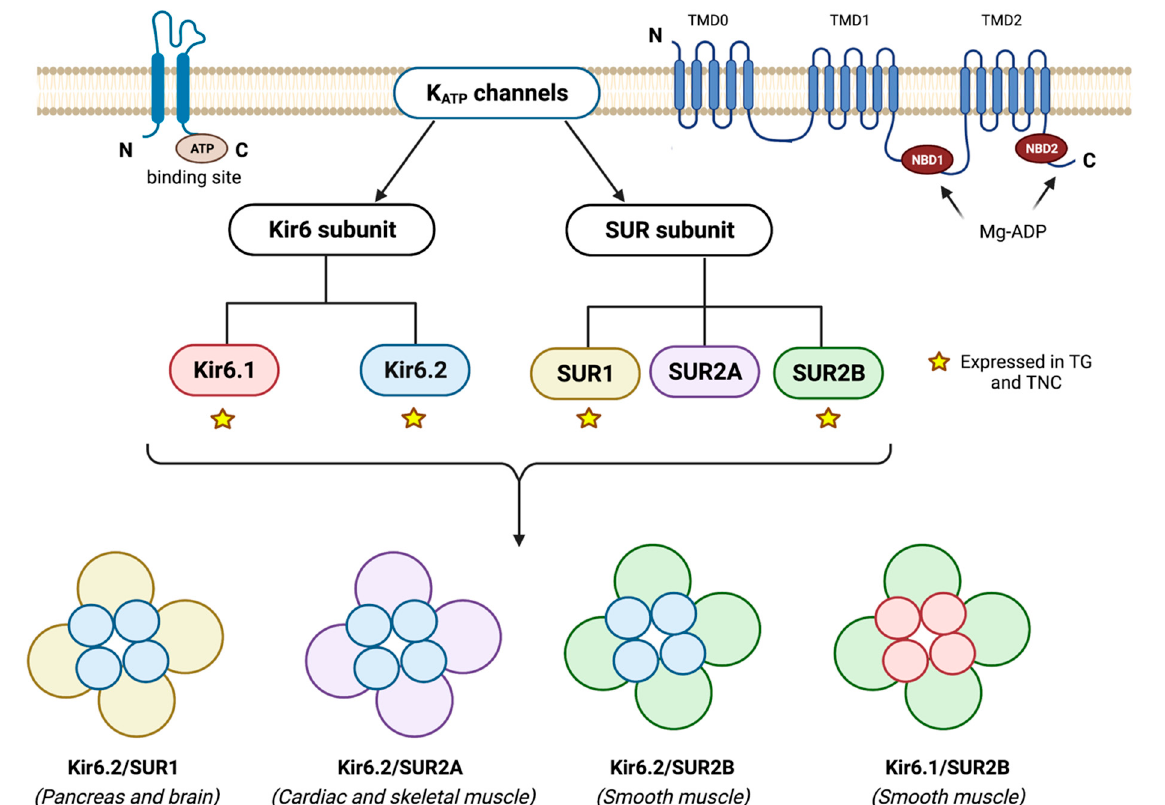
Figure 2. Structure of the K ATP channel. The tetrameric K ATP channel complex is assembled by four Kir6 and four SUR subunits. The Kir6 subunit is a 2 TMD with an ATP-binding site, whereas the SUR subunit consists of 3 components (TMD0, TMD1, and TMD2) with 5–6 transmembrane domains in each. The SUR subunit includes the nucleotide-binding domain (NBD) for Mg-ADP. The distinctive subtypes in each subunit give rise to different combinations and properties of the K ATP channels. Kir6.1, Kir6.2, SUR1, and SUR2B are expressed in TG and TNC. The occurrence of these combinations is presented. Kir6 = inwardly rectifying K + channel; SUR = sulphonyl urea receptor; TG = trigeminal ganglion; TNC = trigeminal nucleus caudalis.